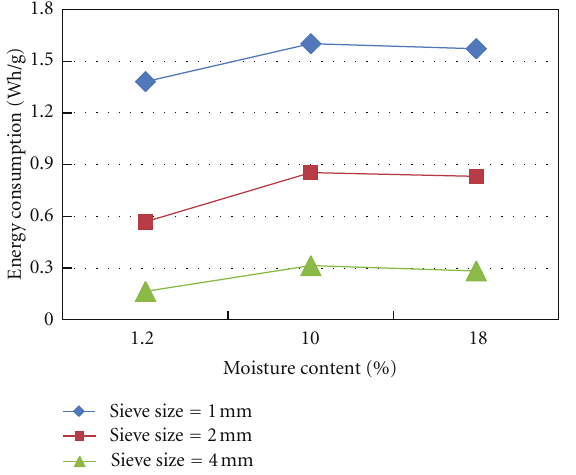
Figure 11: E ff ects of moisture content on energy consumption in knife milling.